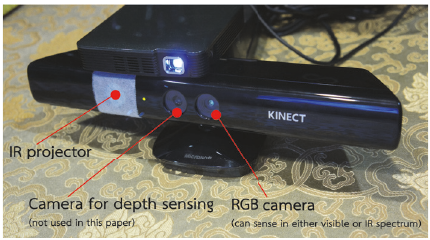
Figure1:OurprototypeofanIR-RGBprojectorfrom[9].Thisfigure shows a simulation of an IR-RGB projector that loosely combines a